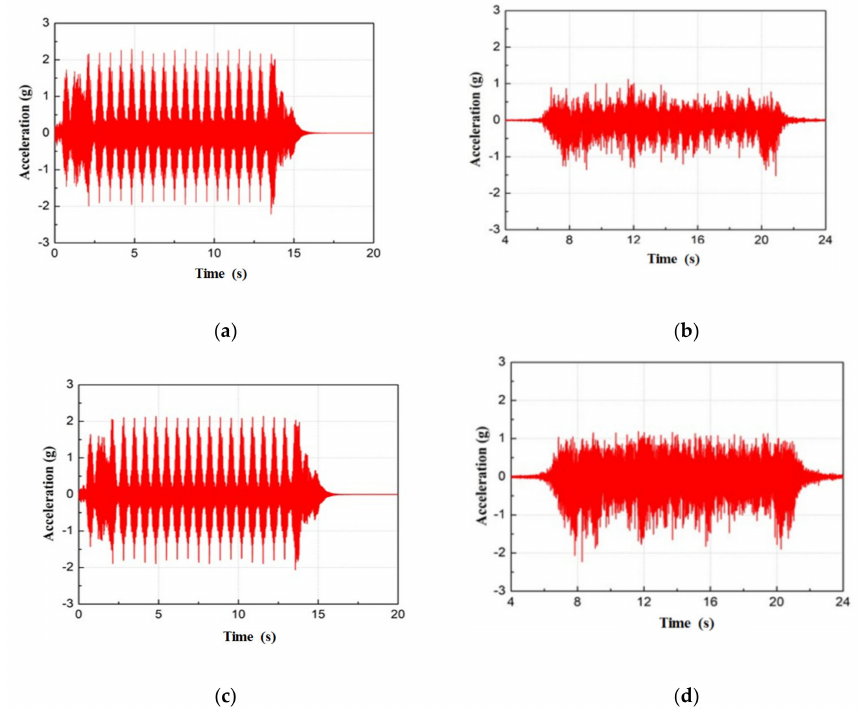
Figure 7. Comparison of rail and track girder vertical accelerations (KTX). ( a ) Rail vertical acceleration (100 km / h, numerical analysis); ( b ) Rail vertical acceleration (98 km / h, field measurement); ( c ) Track girder vertical acceleration (100 km / h, numerical analysis); ( d ) Track girder vertical acceleration (98 km / h, field